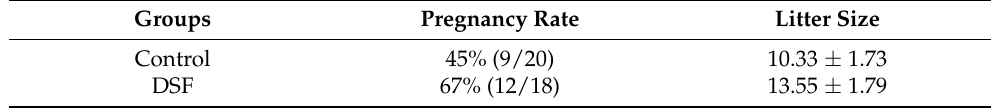
Table 2. Effects of DSF on mouse offspring.